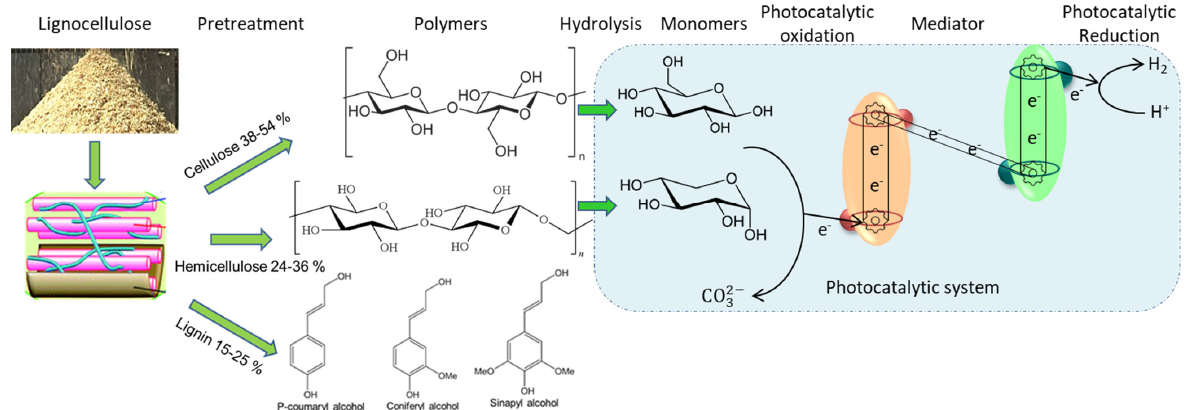
Figure 3. (From left to right) Liberation of sugar monomers from lignocellulose and the Z-scheme dual-photocatalyst system comprising an oxygen evolution photocatalytic semiconductor oxidising the monomers to carbonates, an electron relaying mediator, and a hydrogen evolution photocatalytic semiconductor reducing protons, acting as the anode in the integrated scheme. The photoexcited electron in the oxygen evolution photocatalyst (OEP) jumps the bandgap, leaving positively charged holes in the valence band of the oxygen evolution photocatalyst (Equation (1)).